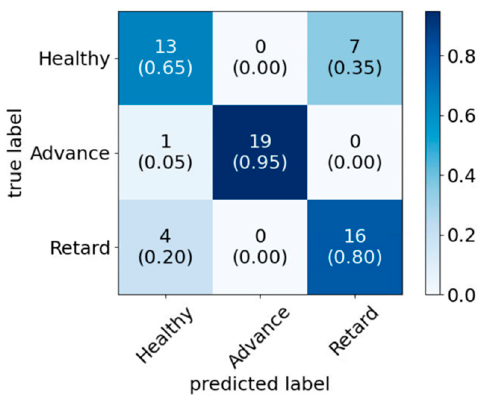
Figure 6. Model 1—confusion matrix and for engine misfire data.